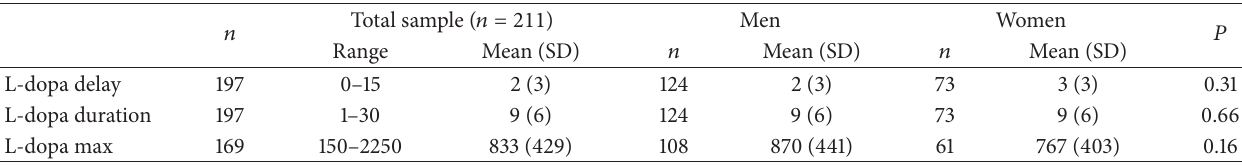
Table 5: Levodopa treatment